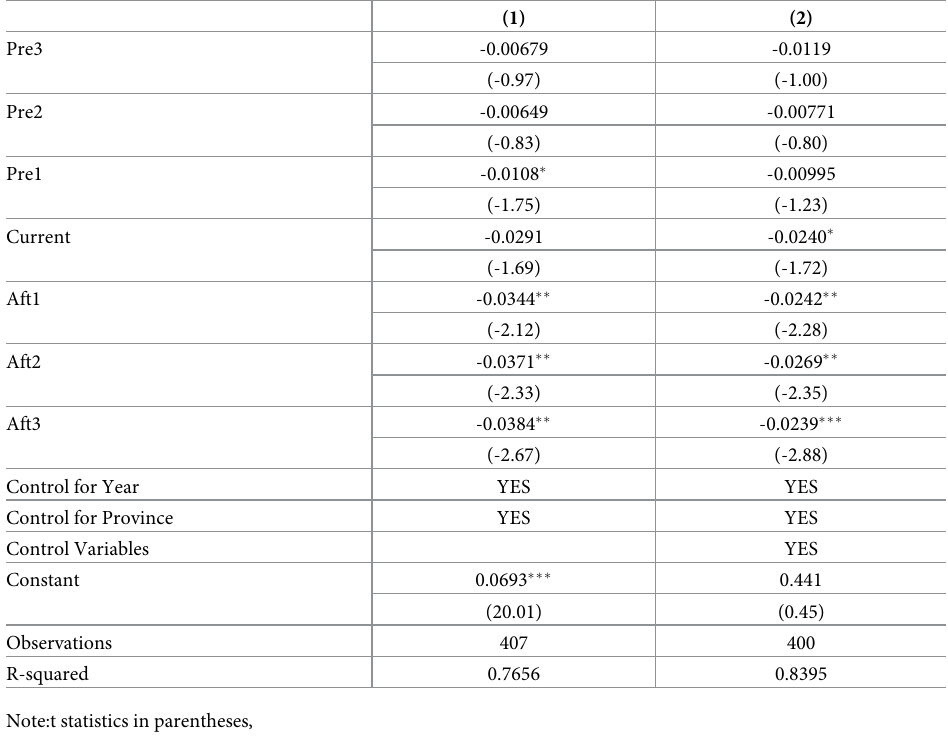
Table 5. Parallel trend